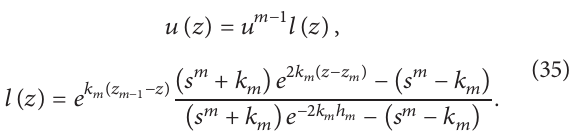
Table 2: Model of the medium 2.